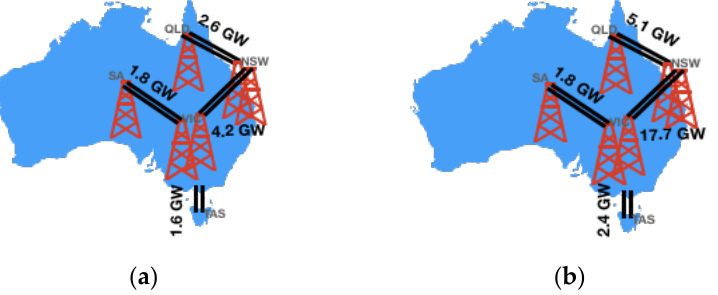
Figure 3. Inter-regional power transmission capacities in the P1.5 °C scenario for different years: ( a ) 2030; ( b ) 2050. ( b )